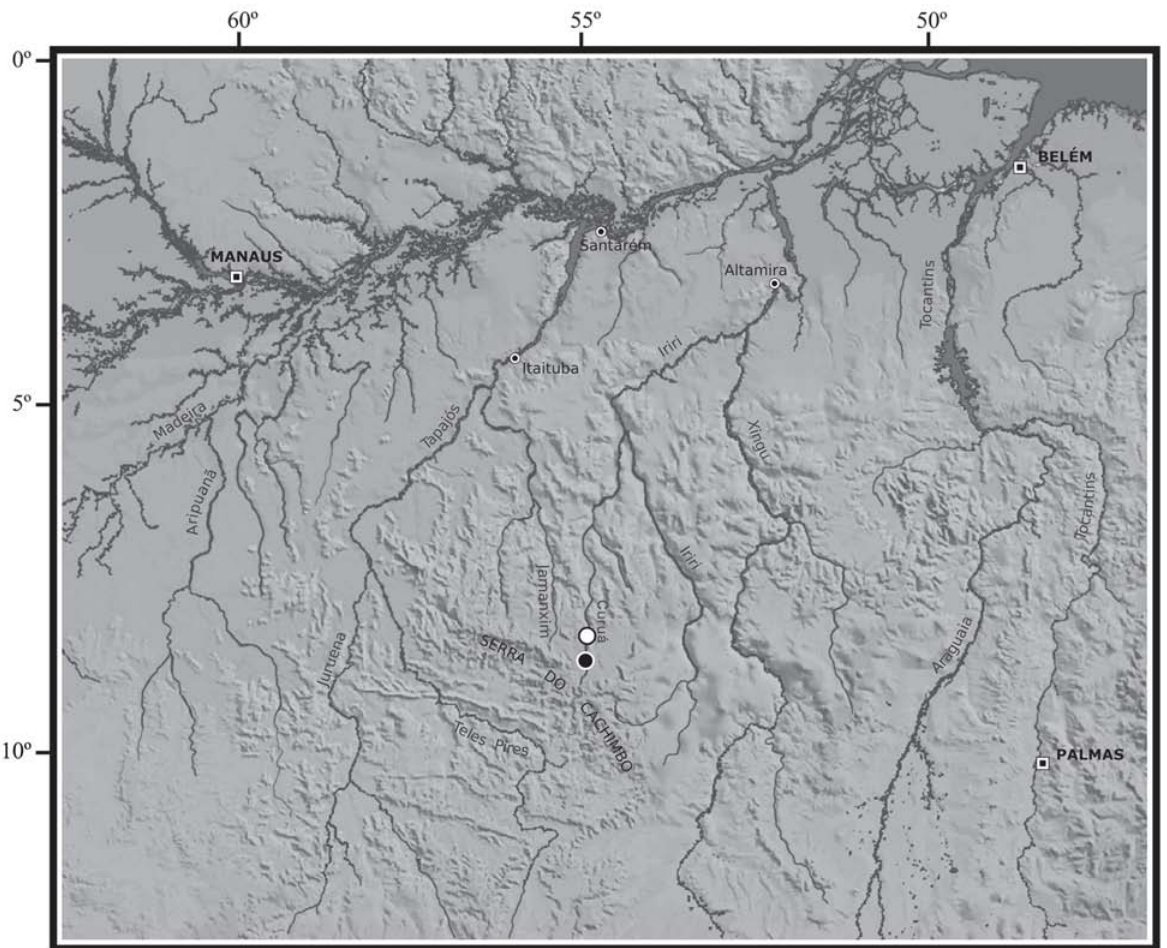
Fig. 5. Rio Xingu basin and adjoining areas, showing the collecting sites (black dots) and type-locality (open dot) of Bryconadenos weitzmani